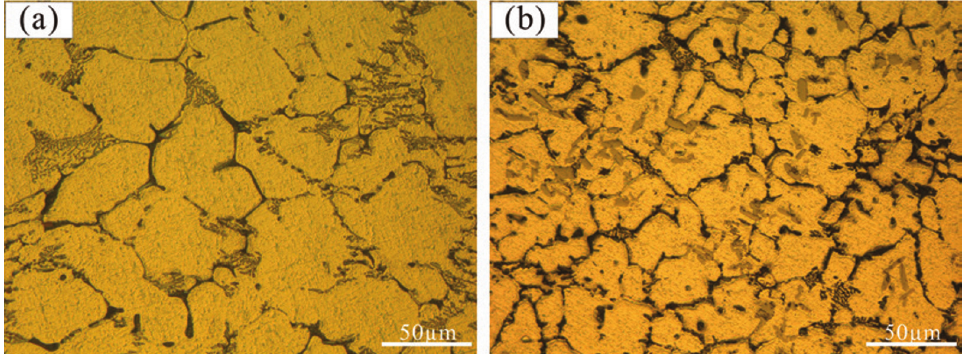
Fig. 1: Microstructures of as-cast alloys: (a) alloy 2618, (b) alloy